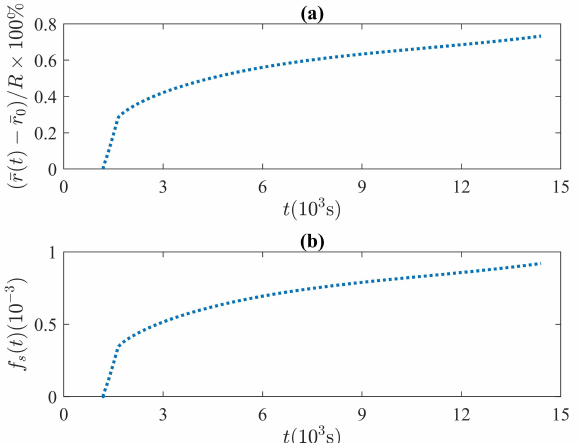
Figure 8. ( a ) Numerical solution to the liquid–solid interface motion. The results illustrate the relation between the liquid’s thickness and the outer radius of the thermal unit, according to the numerical solution of the proposed model with the set of thermodynamic variables shown in Table 2. ( b ) Time evolution of f s obtained from the numerical solutions to the proposed model and with the set of parameters shown in Table